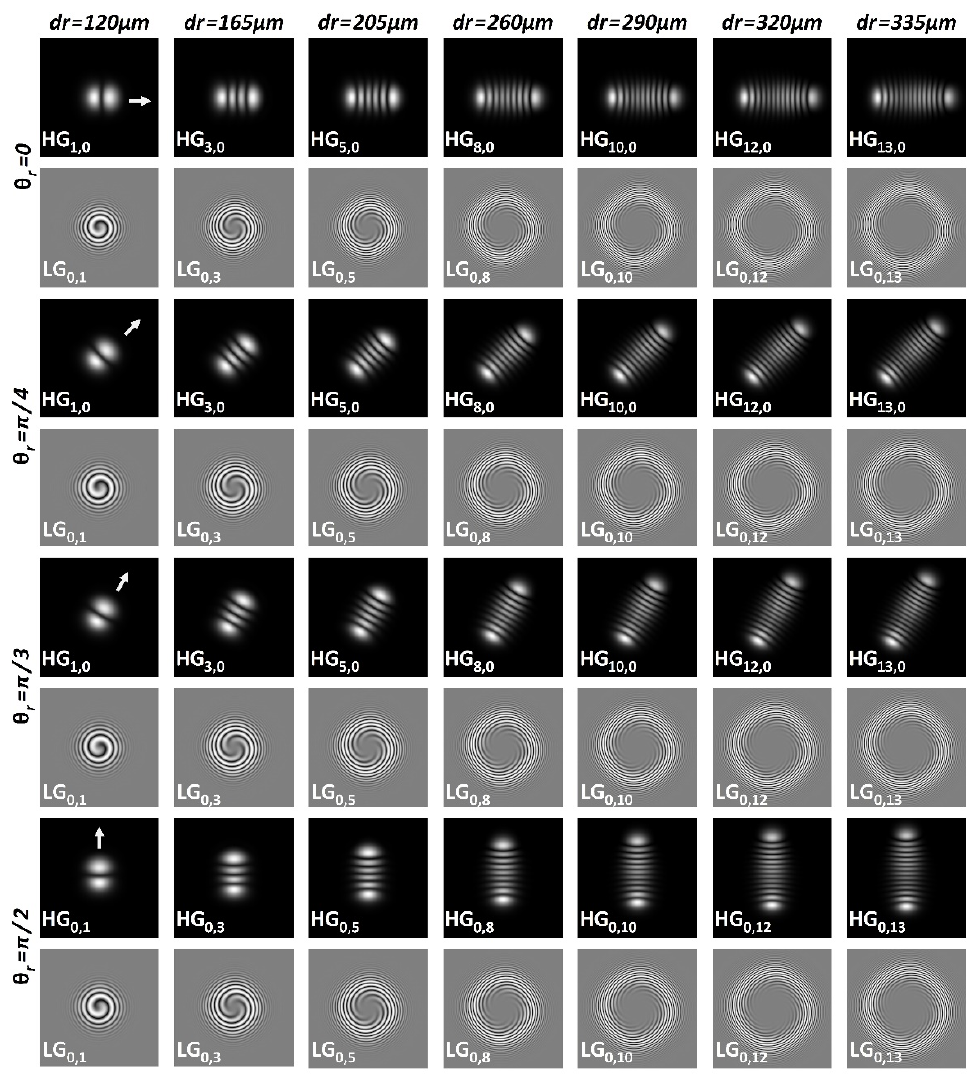
Figure 11. Generation of HG and vortex beams with dual off-axis displacement.